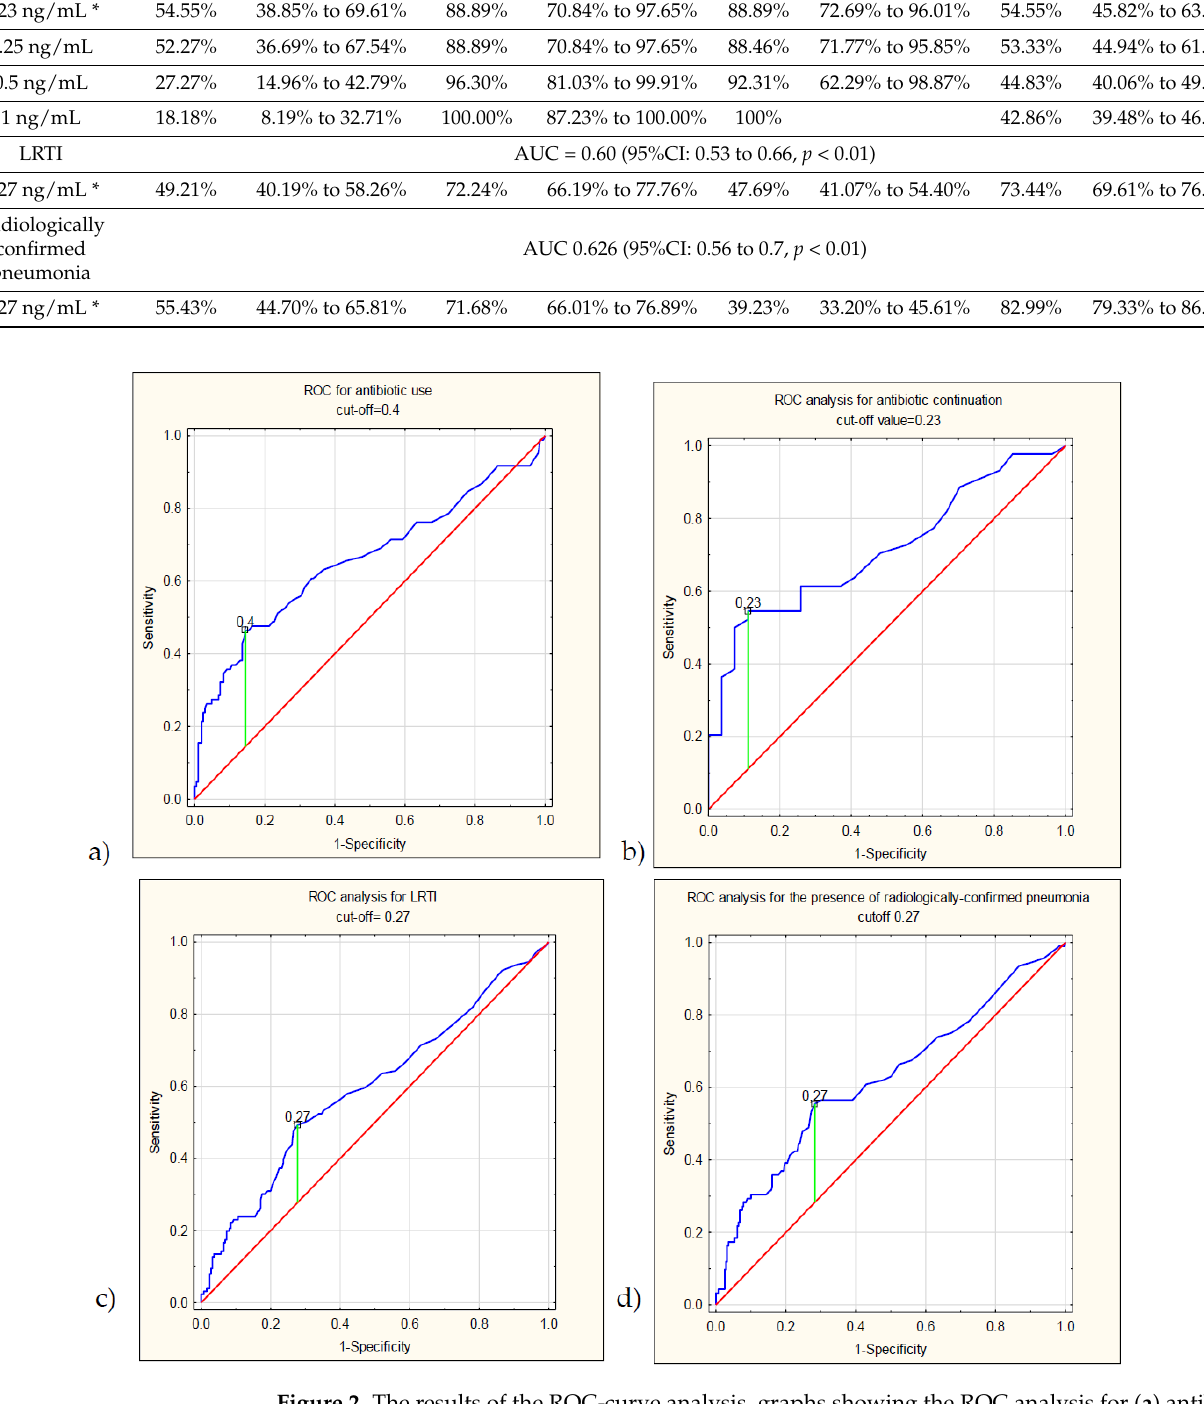
Figure 2. The results of the ROC-curve analysis, graphs showing the ROC analysis for ( a ) antibiotic implementation (No-PAT group), ( b ) antibiotic continuation (PAT group), ( c ) lower-respiratory-tract infection and ( d ) presence of radiologically confirmed pneumonia. Table 3. Procalcitonin performance (at different cut-off values) in the prediction of antibiotic use (No-PAT group), antibiotic continuation (PAT group), lower-respiratory-tract involvement and ra- diologically confirmed pneumonia. Abbreviations: 95%CI — 95% confidence interval, PPV — positive predictive value, NPV — negative predictive value, LRTI — lower-respiratory-tract infection. * Opti- mal cut-off values according to the Youden index. Endpoint Antibiotic use (No-PAT group)